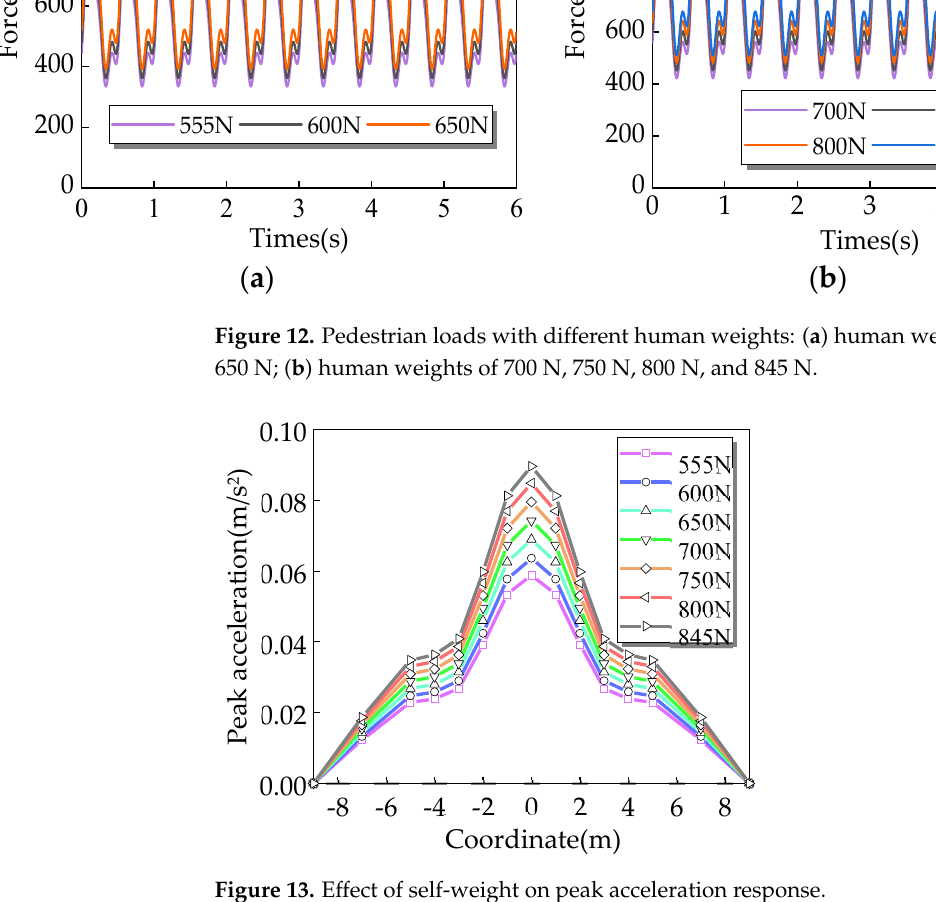
Table 5. Variation range of parameters.